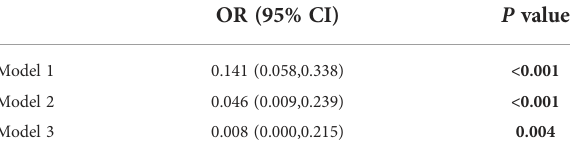
TABLE 3 Regression analysis of serum vitamin D and the risk of developing poorer sleep quality in